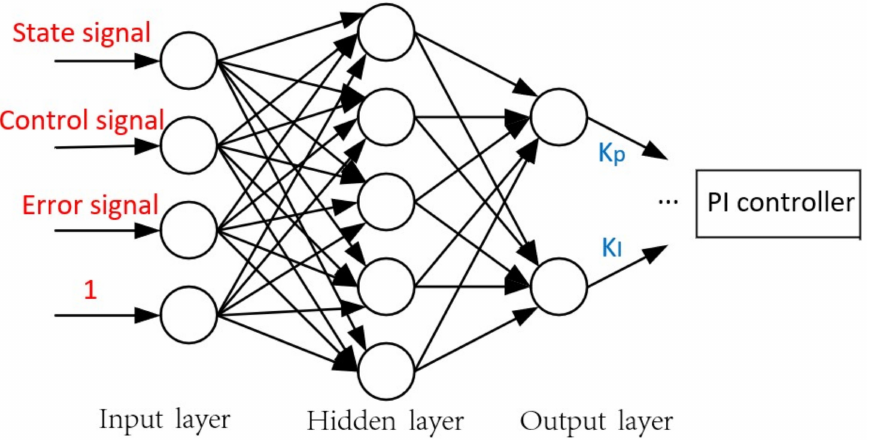
Figure 3. Structure of BP neural